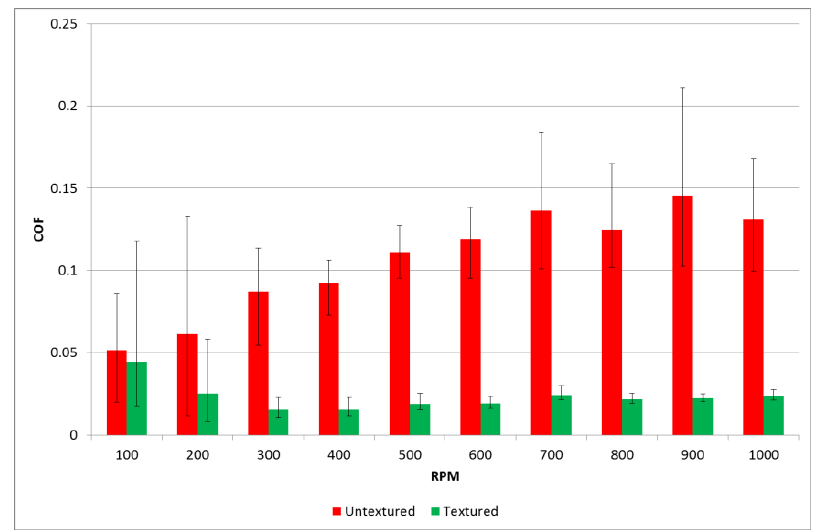
Figure 10. Average values and scatters of the coefficient of friction for textured and untextured samples at a normal load of 20 N.